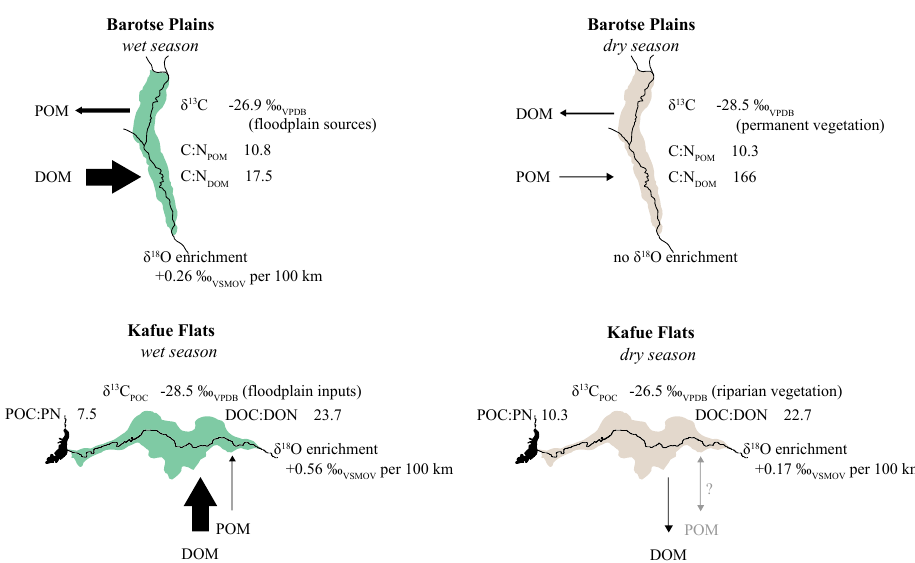
Figure 7. Summary of the organic-matter characteristics ( δ 13 C, POC:PN, DOC:DON) and oxygen isotopic enrichment along the floodplain during the wet and dry season in the Barotse Plains and Kafue Flats. Proportional arrows indicate net export from the floodplain to the river (arrow towards the system) and removal rates of material from the river to the floodplain (arrow away from the system) of POM (POC + PN) and DOM (DOC +